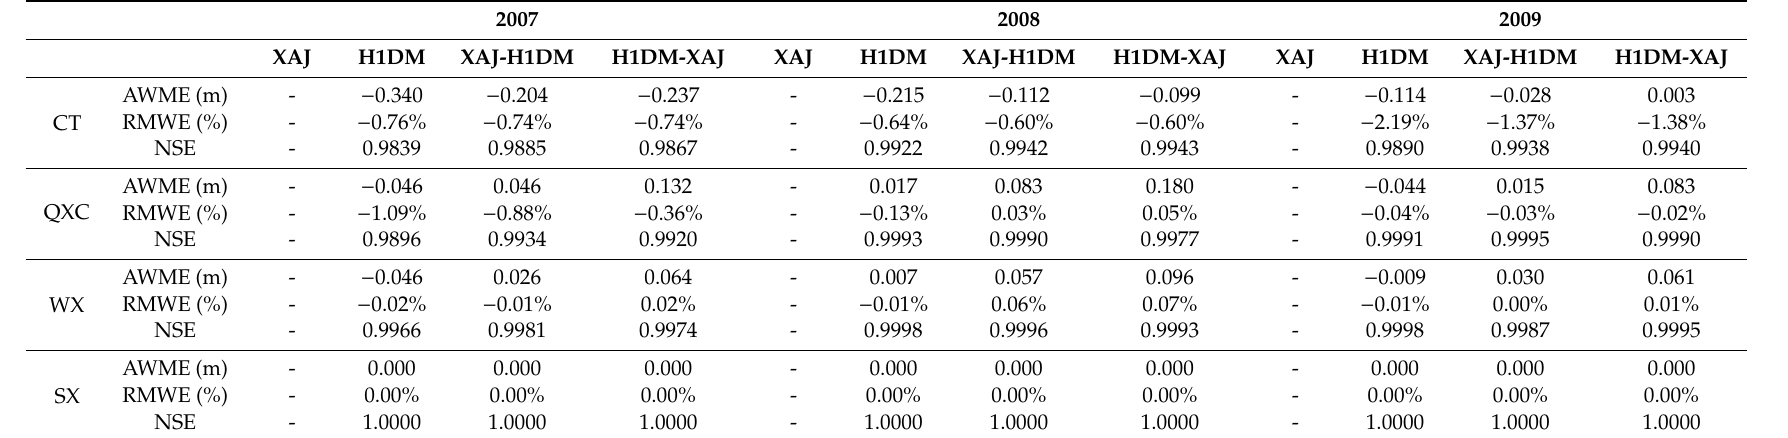
Table 4. Accuracy statistics of the four model water level simulations with calibrated parameters for both calibration and validations